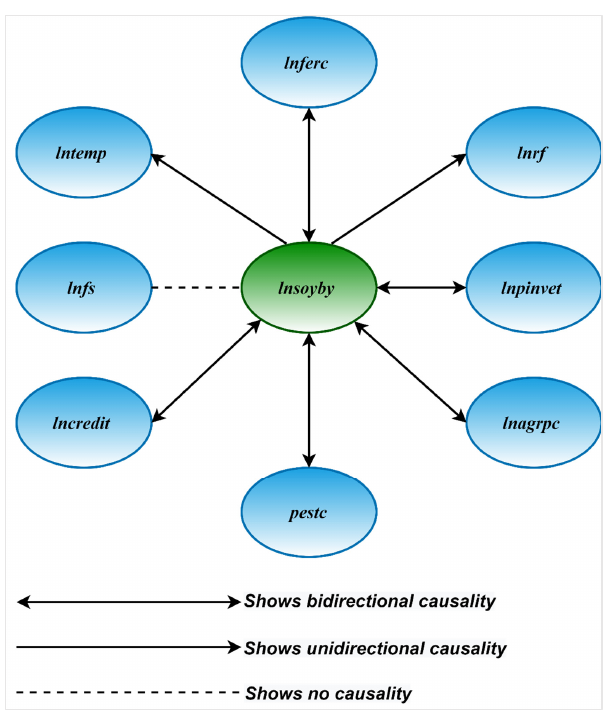
Figure 5. Key findings of the D–H test.